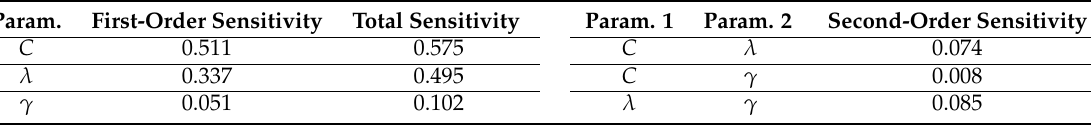
Table 3. Sensitivity analysis using Sobol